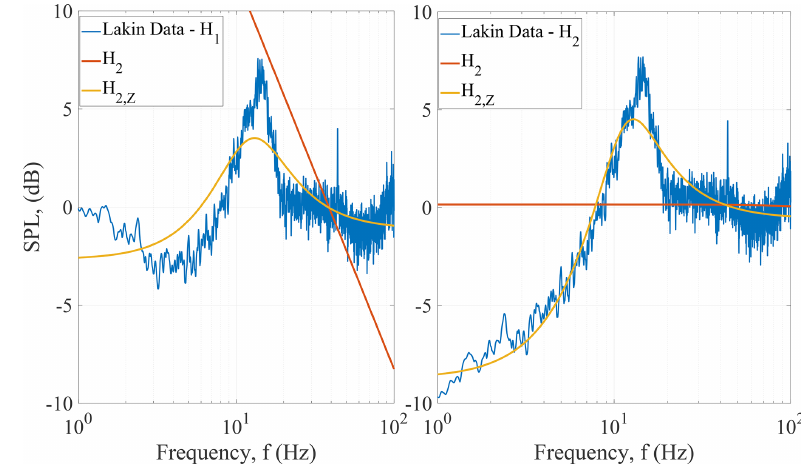
Figure 15. Secondary curve fits to Lakin, KS, tornado measurements with select first-stage fits subtracted. Table 4. Fit parameters for the four model